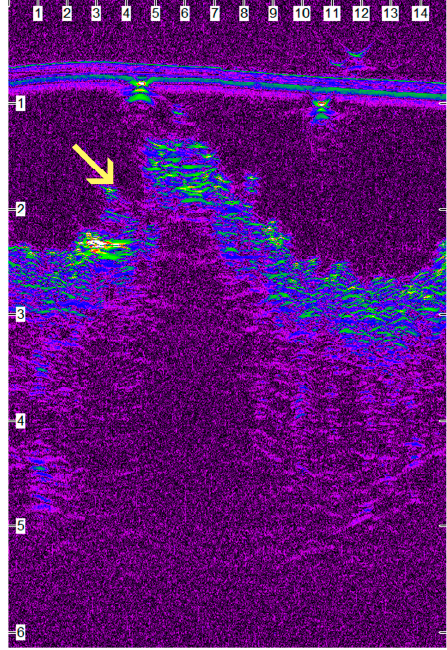
Figure 12. Ultrasonographic image of the wound area closed with glue, on the 9th po.d. The epithe- lial gap is evident between the epididymal edges at the wound area (arrow). The image is com- pressed laterally to facilitate viewing (scale is in mm).